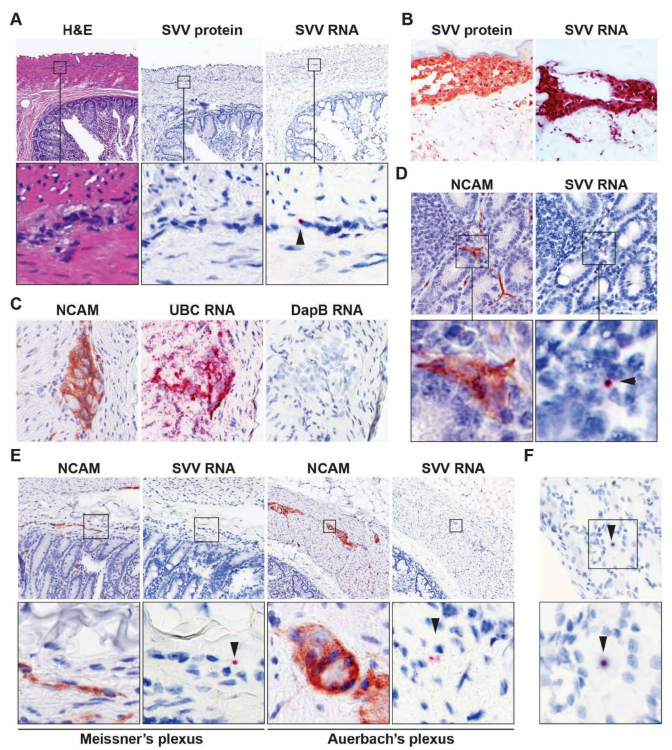
Figure 1. Detection of viral RNA in enteric neurons of latently simian varicella virus (SVV)-infected rhesus macaques. ( A ) Consecutive intestine sections from latently SVV-infected rhesus macaques (RM) were stained with hematoxylin and eosin (H&E), immunohistochemically (IHC) stained for SVV nucleocapsid protein or stained for SVV ORF63 RNA by in situ hybridization